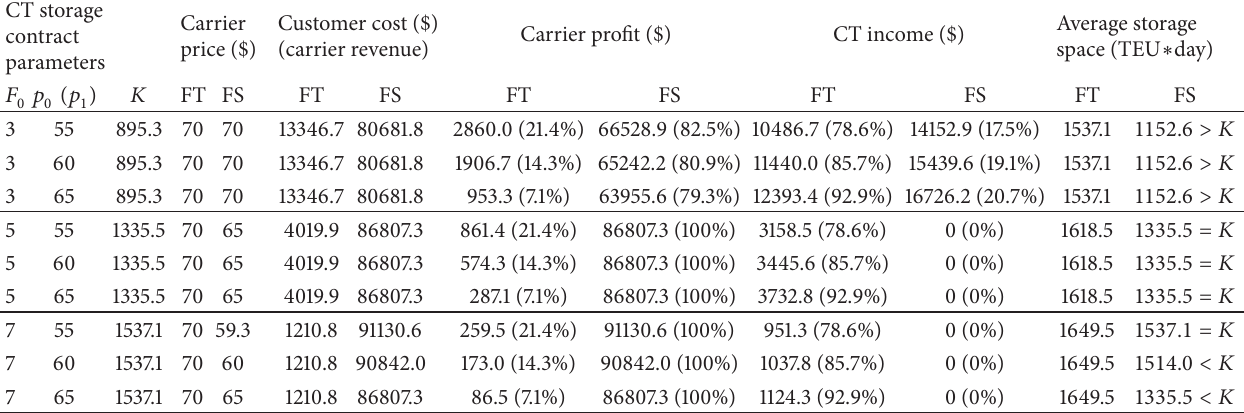
Table 2: Numerical results under different container terminal storage contract parameter settings.